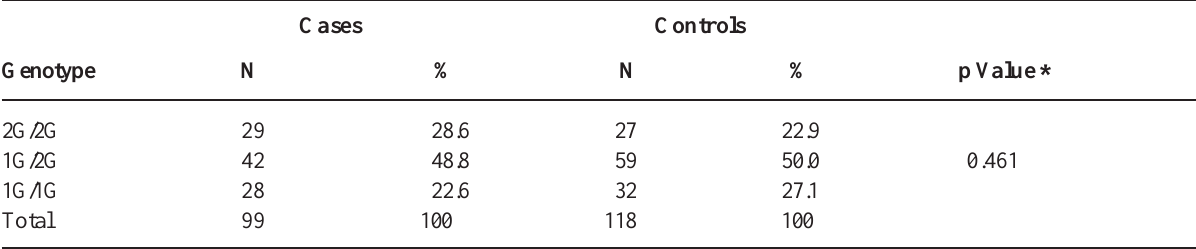
Table 3 – Distribution of MMP-1 polymorphism in case and controls.